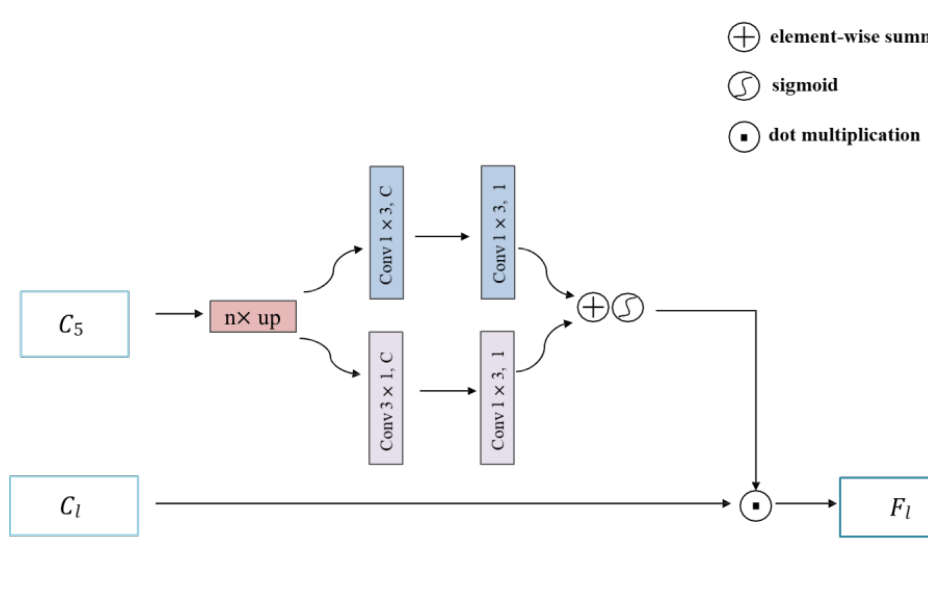
Figure 4. The spatial attention structure.